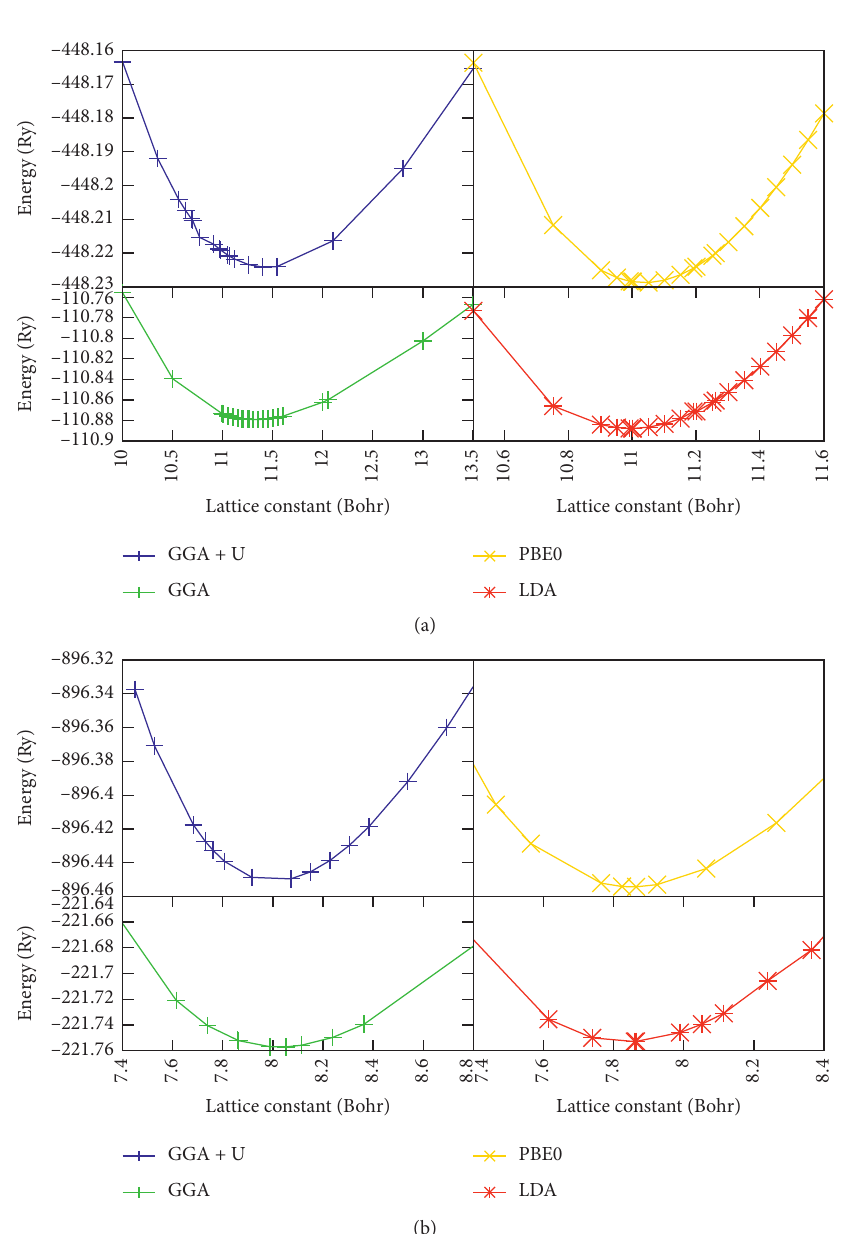
Figure 1: Lattice constant versus total energy of CdS in zb (a) and wz (b)